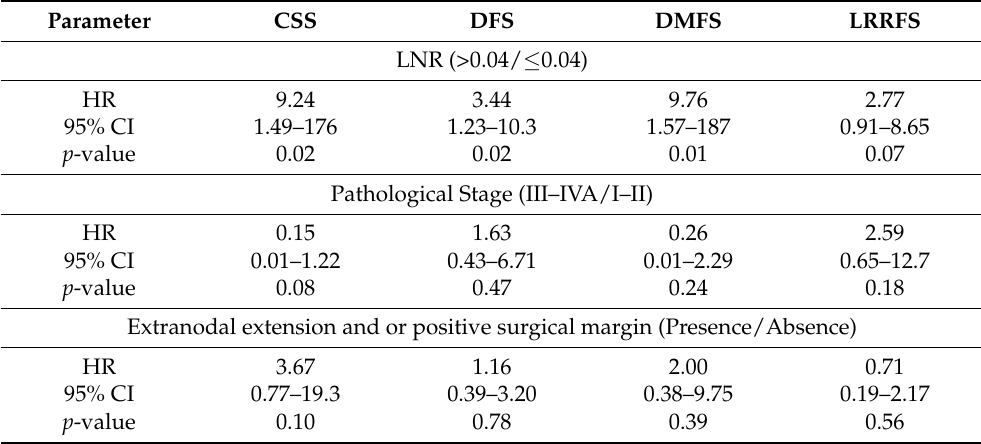
positive surgical margin LNR = lymph node ratio. Table 3. Multivariate survival analyses by Cox’s hazard proportional